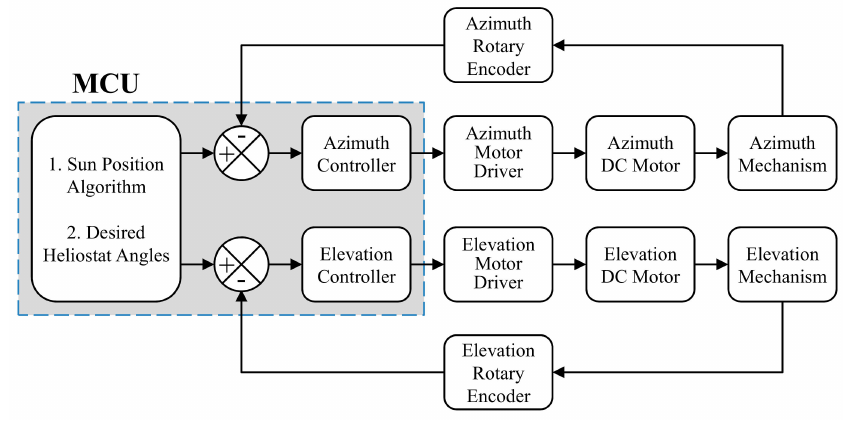
Figure 9. Block diagram of the orientation control algorithm.